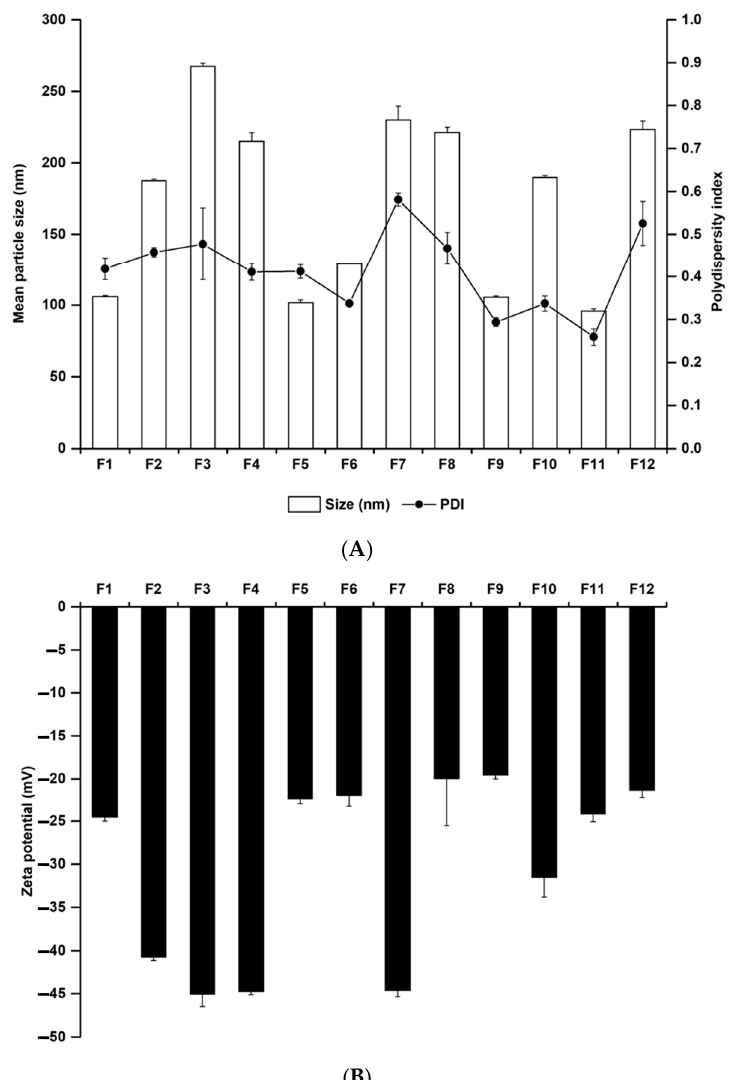
Figure 3. Physicochemical characteristics of ( A ) average particle size and PDI and ( B ) zeta potential for MPa-loaded nano-transfersomes prepared using different materials. Results are expressed as the means ± standard deviations of three independent experiments ( n = 3). MPa, methyl pheophorbide-a; PDI, polydispersity index.